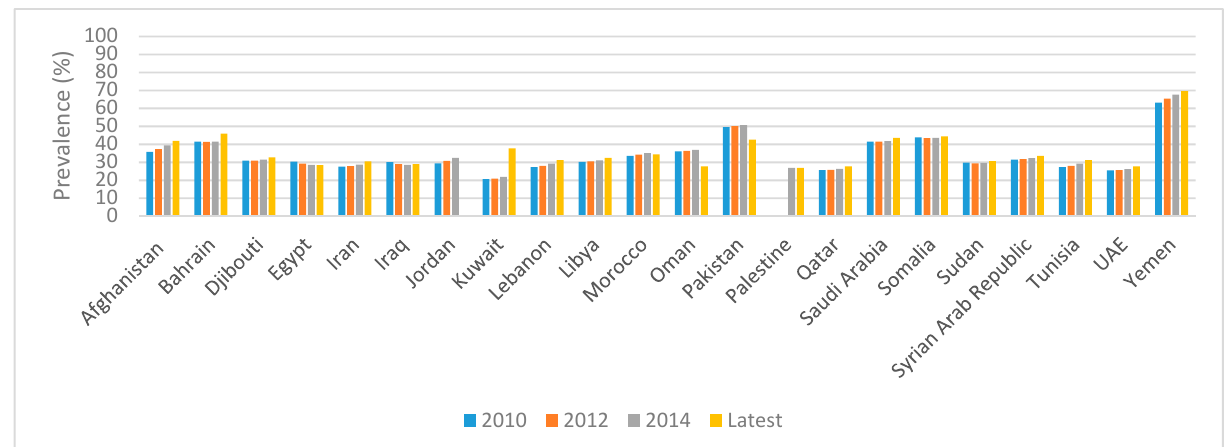
Figure 1. Trends in the prevalence of anemia amongst WRA (15–49 years) in countries of the EMR. References: 2010, 2012, and 2014 data were based on the WHO GHO Database [27]. The latest data were based on the WHO GHO Data Repository–Prevalence of anemia in women (2016) [27] and on the WHO EMRO Monitoring health and health system performance in the Eastern Mediterranean Region, Core indicators and indicators on the health-related Sustainable Development Goals 2019 [30], with the following exceptions: the data for Morocco were based on the recent Moroccan NNS 2019–2020 [37]. The data for Oman were based on the recent Oman NNS in 2017 [36]. The data pertinent to Pakistan were based on the recent NNS 2018 [32]. Anemia was defined as an Hb concentration < 120 g/L, adjusted for altitude and smoking. Abbreviations: EMR: Eastern Mediterranean Region; EMRO: Regional Office for the Eastern Mediterranean; GHO: Global Health Observatory; Hb: hemoglobin; NNS: National Nutrition Survey; UAE: United Arab Emirates; WHO: World Health Organization; WRA: women of reproductive age.